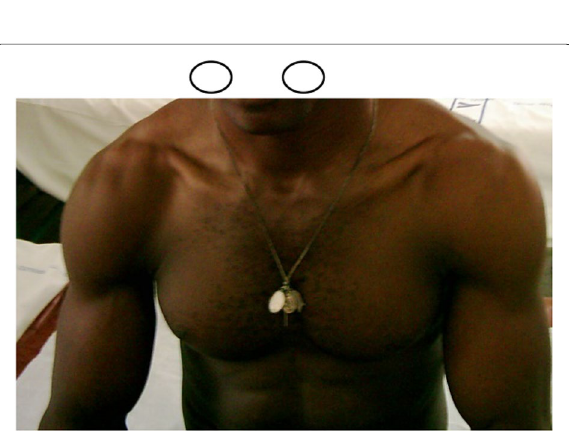
Fig. 2 Neck, arms and thoracic muscular hypertrophy